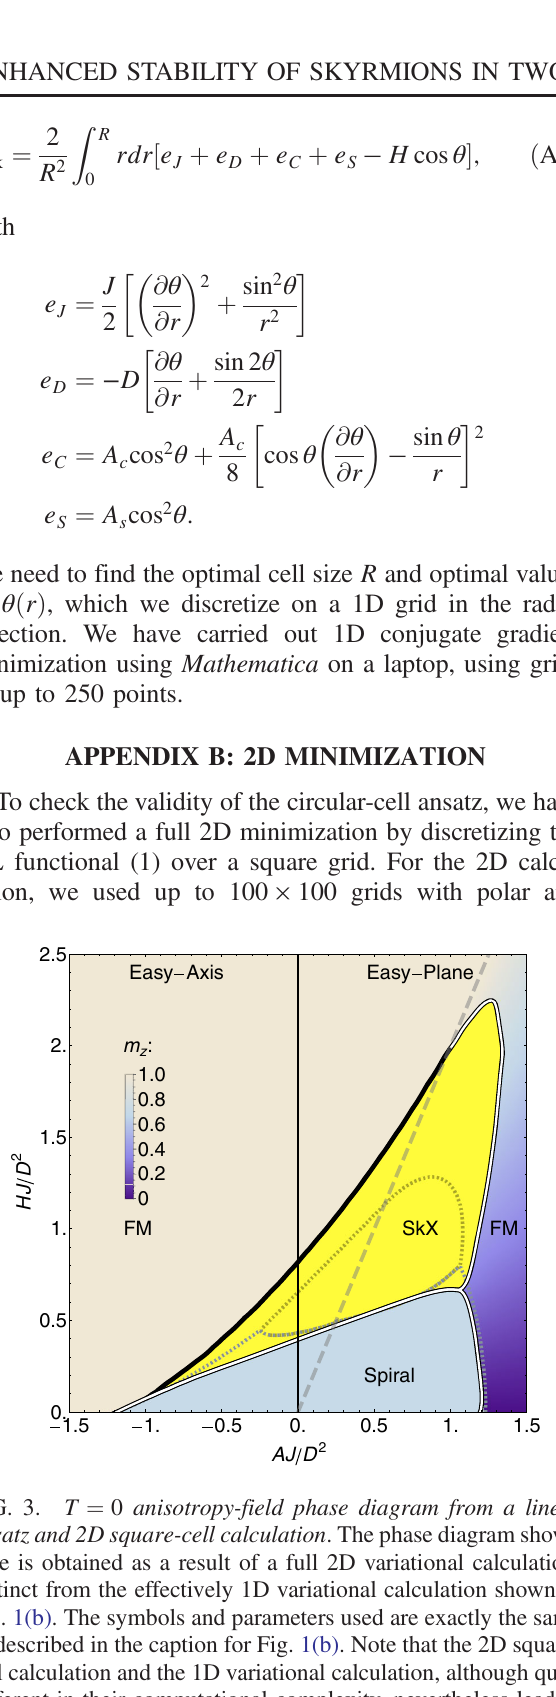
linear ” variational ansatz for SkX described in text.